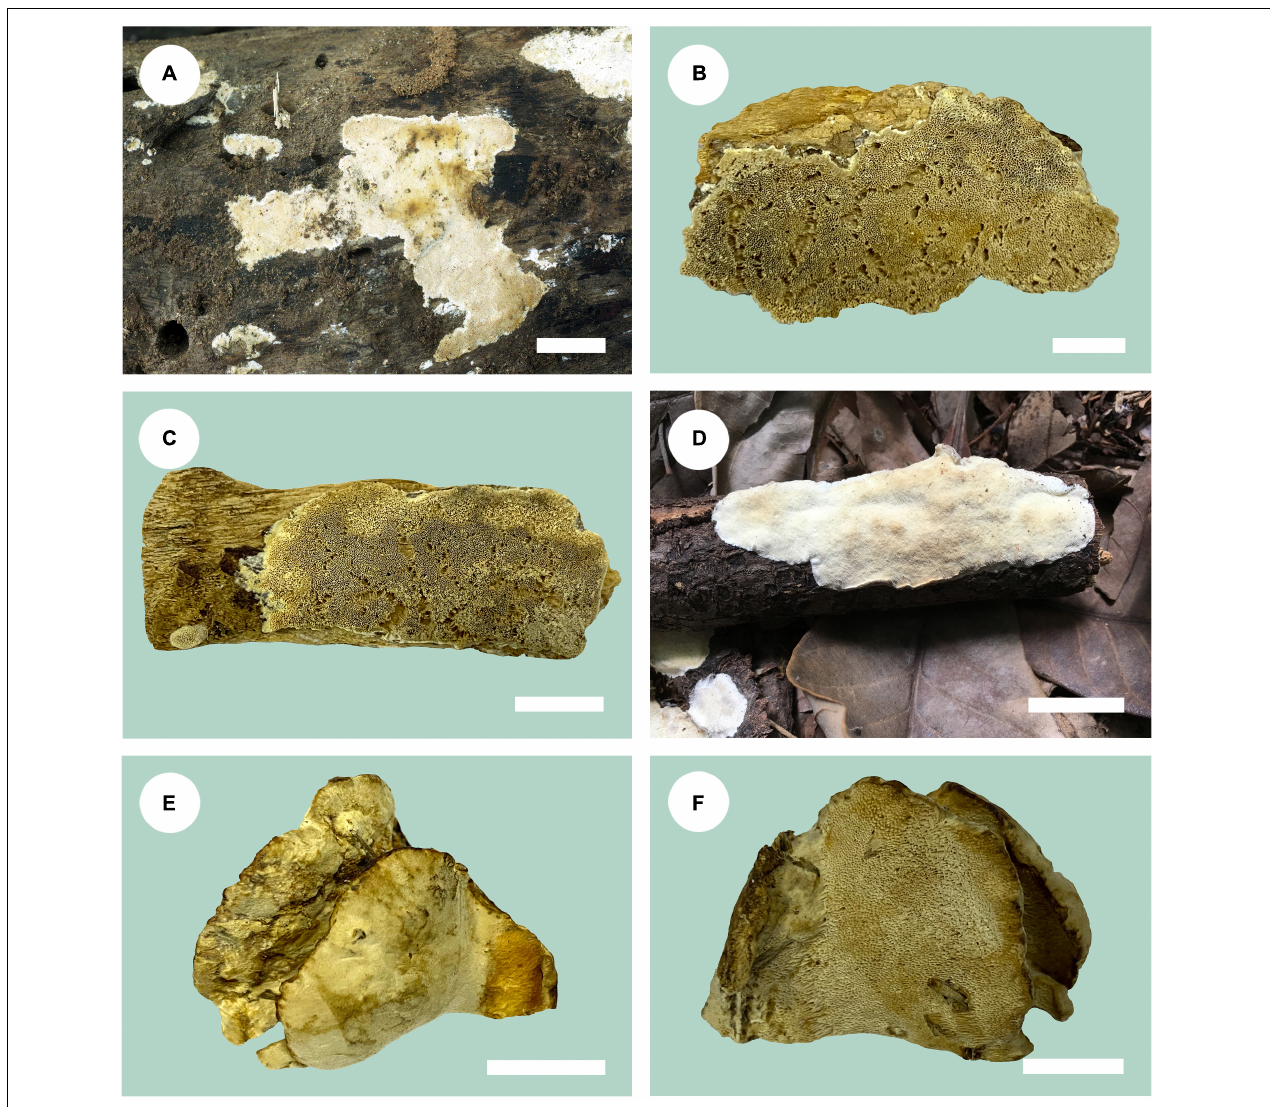
FIGURE 2 | Basidiomata of Fomitopsis species. (A) F. resupinata ; (B,C) F. srilankensis ; (D) F. submeliae ; (E,F) F. yimengensis (scale bars: b, f = 1.5 cm; a, c, e = 2 cm; d = 3